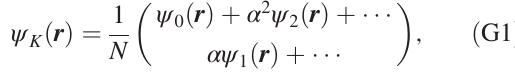
FIG. 12. (a) The value of the Dirac velocity at the Dirac cone for the Hamiltonian Eq. (F2) with a broken C 4 symmetry. The codimension of the zero Dirac velocity manifold is two (the dark point). (b) The values of the “ signed ” Dirac velocity f [as defined in Eq. (5)] going through two different trajectories. Since the wave functions are discontinuous at the magic angle, the velocities acquire an opposite sign.